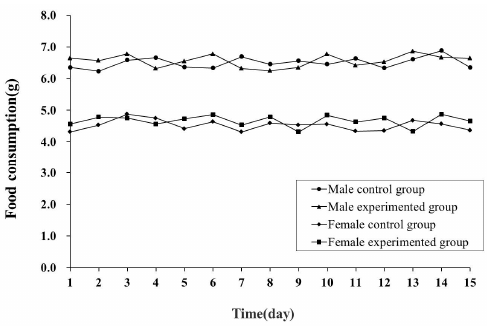
Figure 1. Food consumption of mice in the acute toxicity test.